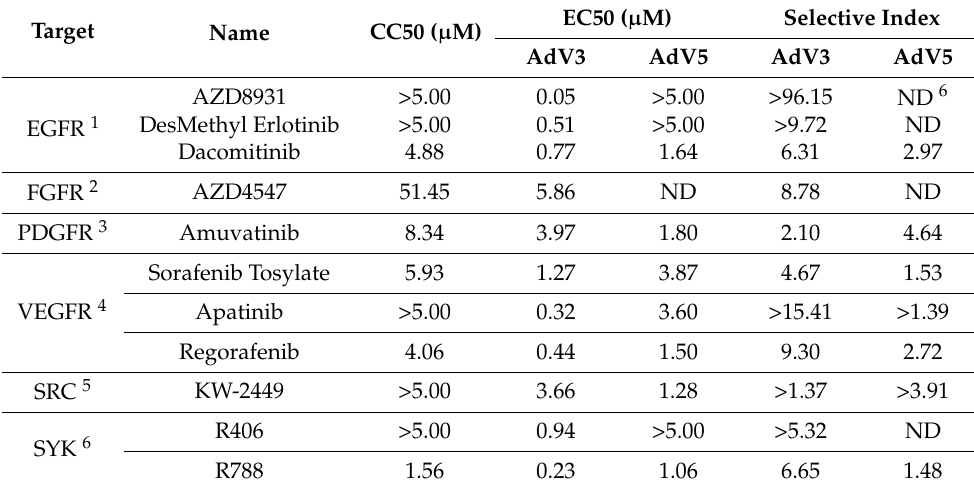
Table 3. Anti-ADV activities of hit compounds targeting protein tyrosine kinase.